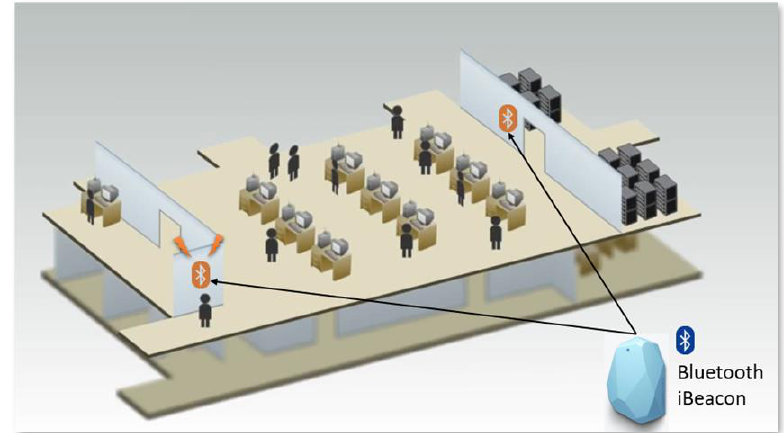
Figure 5. Indoor positioning with Bluetooth iBeacons.